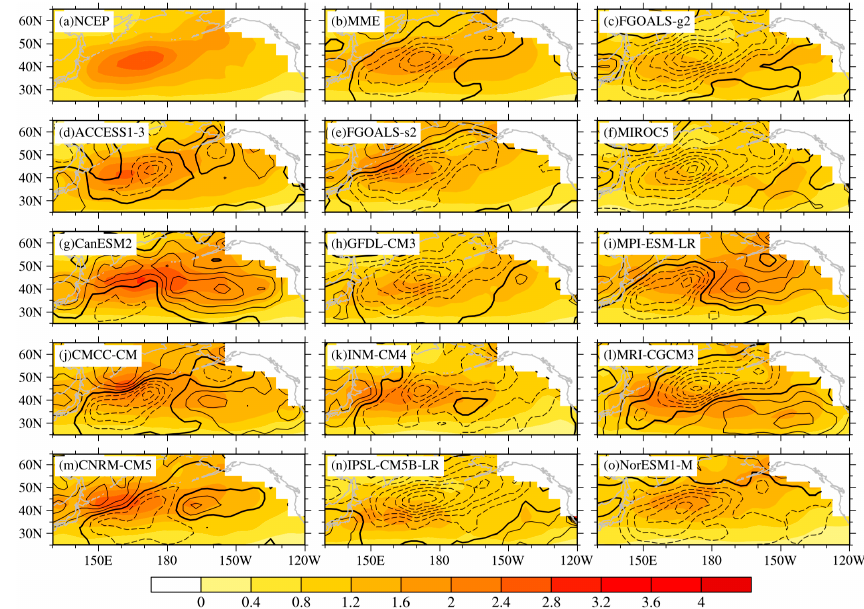
Figure 4. Interannual standard deviation of the climatological WNPST amplitude (shading) from reanalysis and difference between each model and reanalysis (contour, with an interval of 0.2 and black bold contour represent zero line) (unit: K ∙ ms − 1 ).